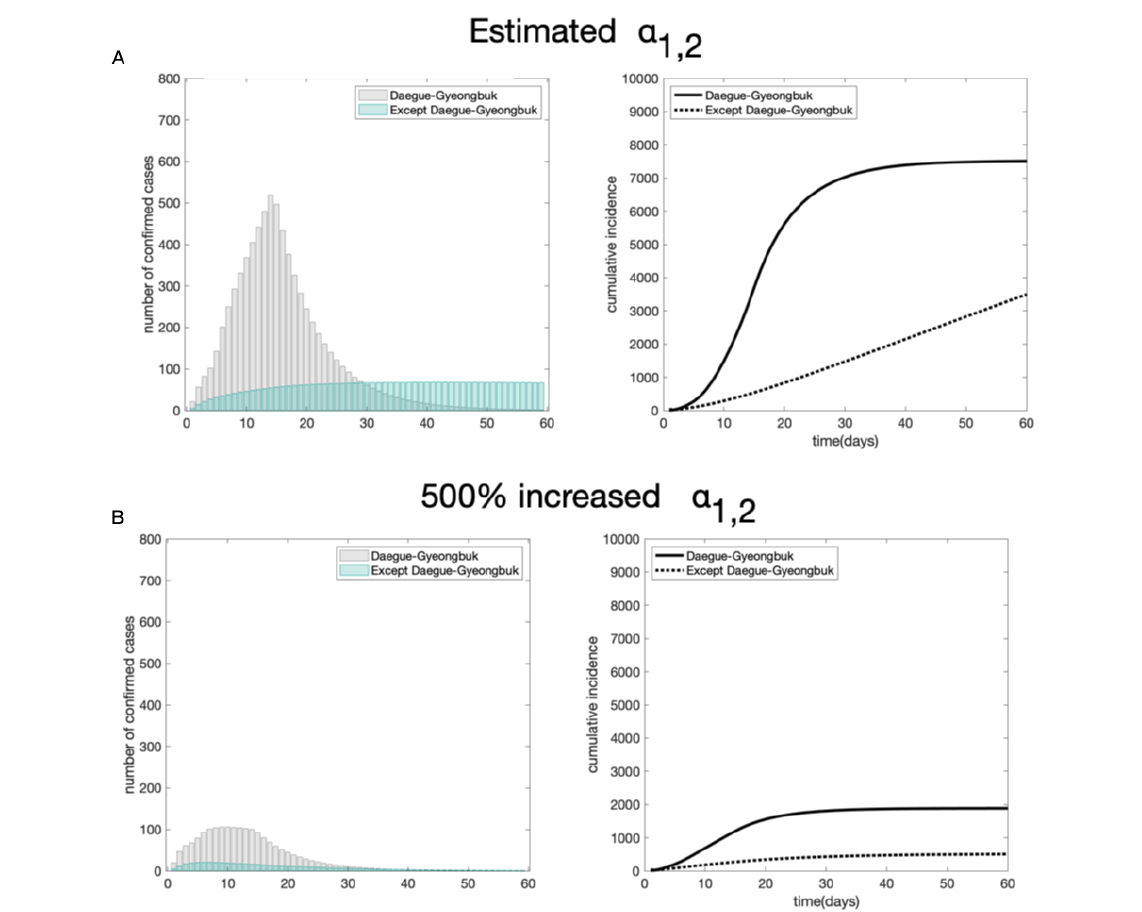
Figure 10. The impact of different early detection rate on daily incidences and cumulative incidences. ( A ) Early detection rate is assumed as estimated α 1,2 . ( B ) The effect of 5 fold increase of the detection rate on the